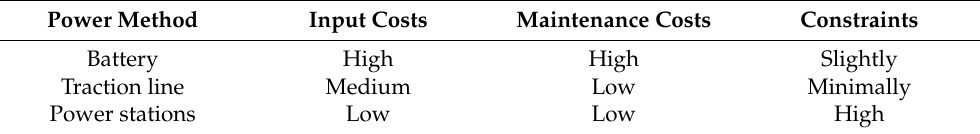
Table 5. The impact of how the manufacturing island is